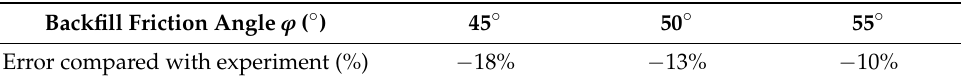
Table 4. Effect of the backfill friction angle on the numerical acceleration at failure A fail of the wall with a slenderness H/B = 2.7.